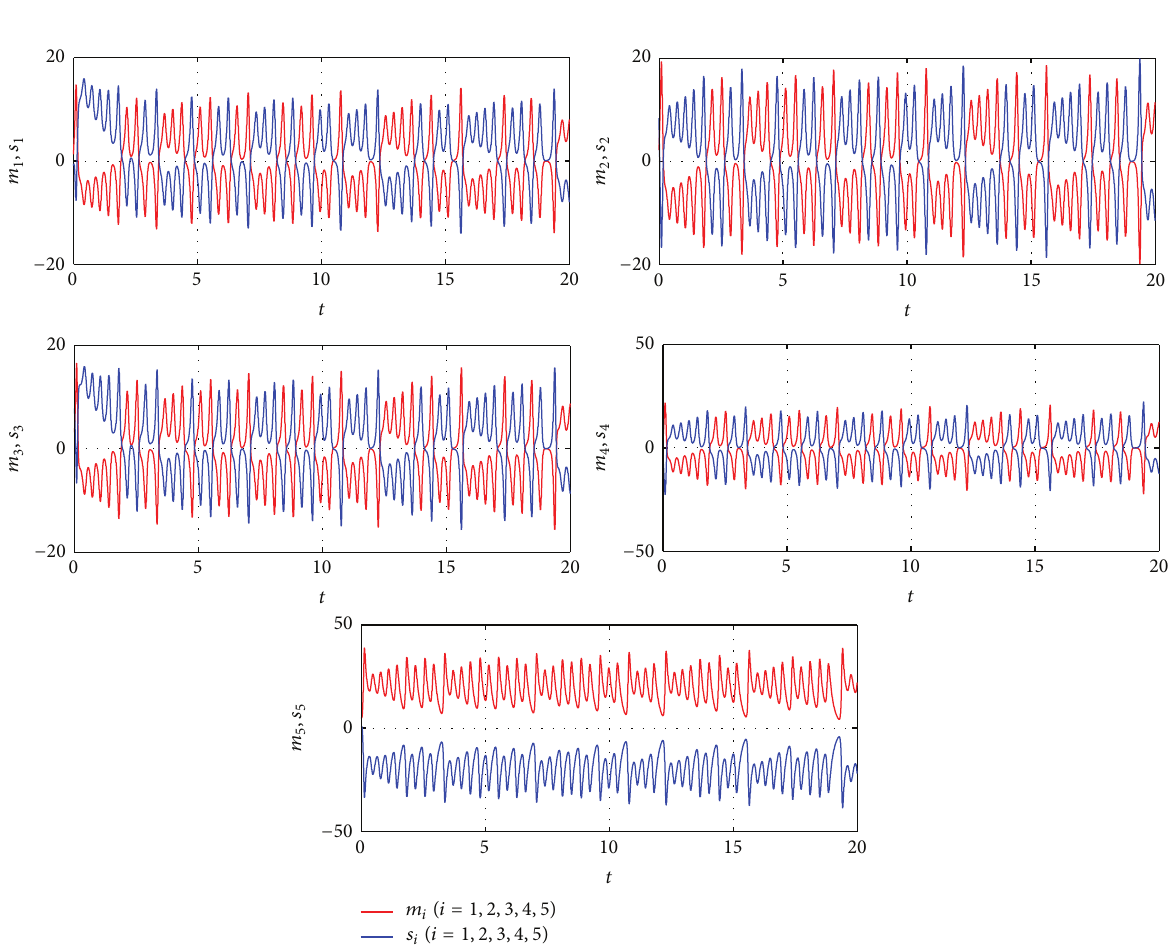
Figure 12: State variables of master system (15) and slave (17)